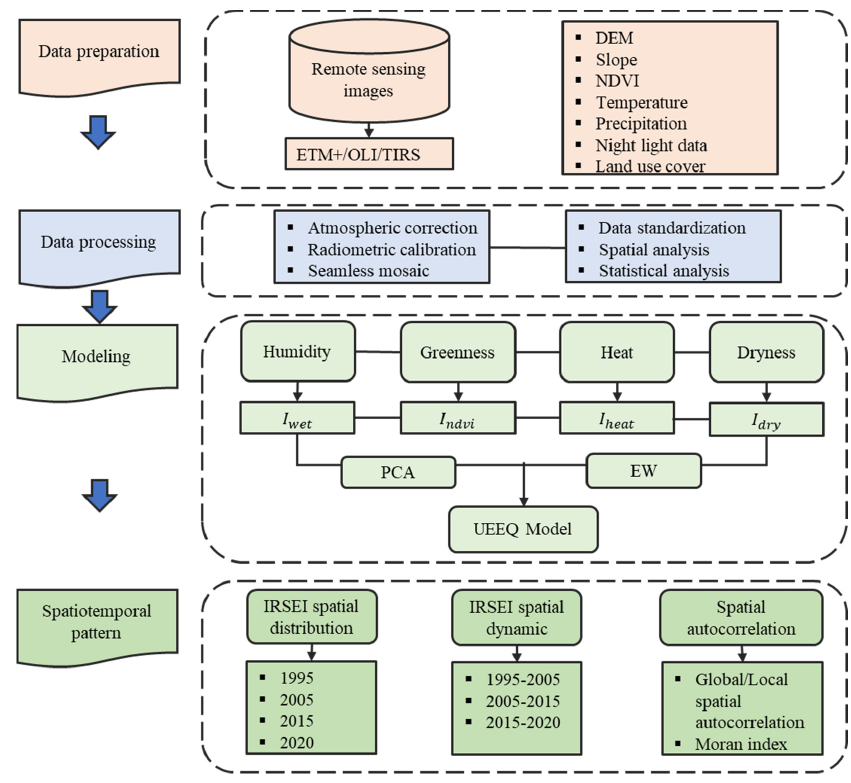
Figure 2. Overall methodological framework.